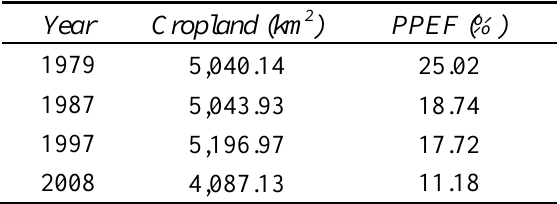
Table 10. Changes of cropland and proportion of population engaged in farming (PPEF) in the study